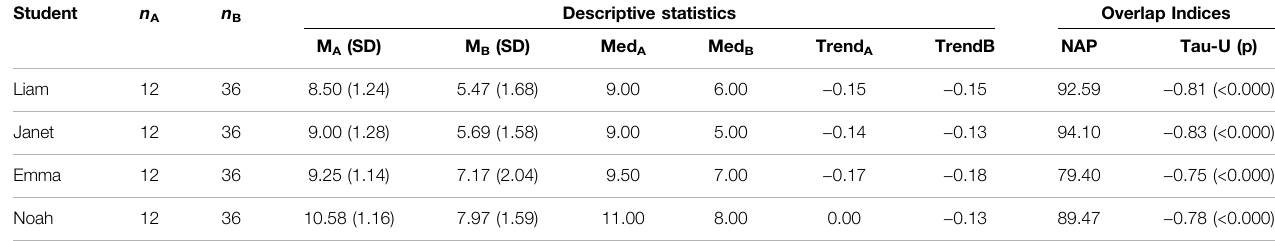
TABLE 2 | Descriptive Statistics and Overlap Indices for the DBR-MIS Sum Scores for each Student. Student